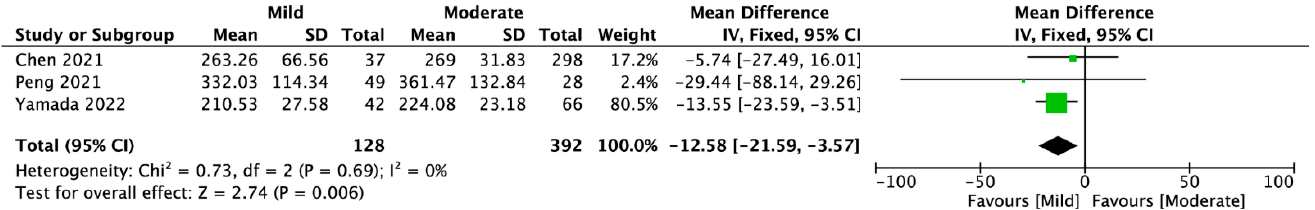
Figure 4. Forest plot of Krebs von den Lungen-6 levels (U/mL) among mild and moderate COVID-19 patient groups. The center of each square represents the mean differences for individual trials, and the corresponding horizontal line stands for a 95% confidence interval. The diamonds represent pooled results [14,23,28].